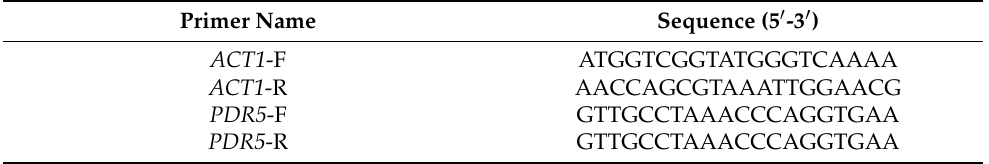
Table 2. Primers used for